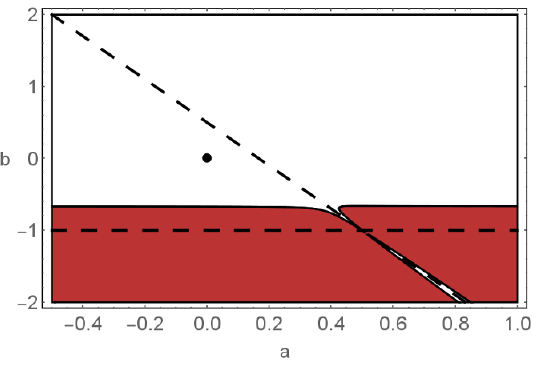
Figure 4 . The red region corresponds to the sub-space of higher curvature parameters, a and b , where the viability condition for a UV completion of the Yukawa sector, i.e., (cid:0) f y = (cid:0) (cid:1) (cid:17) + 1 (cid:17) (cid:30) + D y < 0, is satis(cid:12)ed. The dashed lines indicate the poles 1 + b = 0 (TT-mode) and 2 grav 1 (cid:0) 6 a (cid:0) 2 b = 0 ( (cid:27) -mode). The black dot marks the Einstein-Hilbert